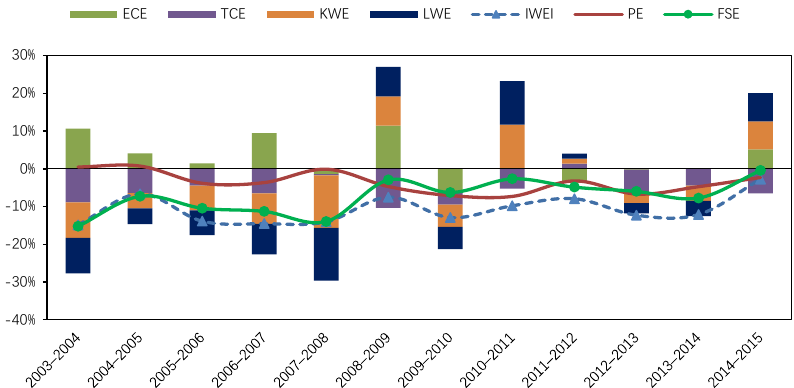
Figure B2. Driving factors of industrial wastewater emission intensity change in the North Area, 2003 – 2015. ECE: the effect of technical efficiency change; TCE: the effect of technological change; KWE: the effect of capital – wastewater substitution; LWE: the effect from labor – wastewater substitution; IWEI: industrial wastewater emission intensity; PE: productivity effect; FSE: factor substitution effect.